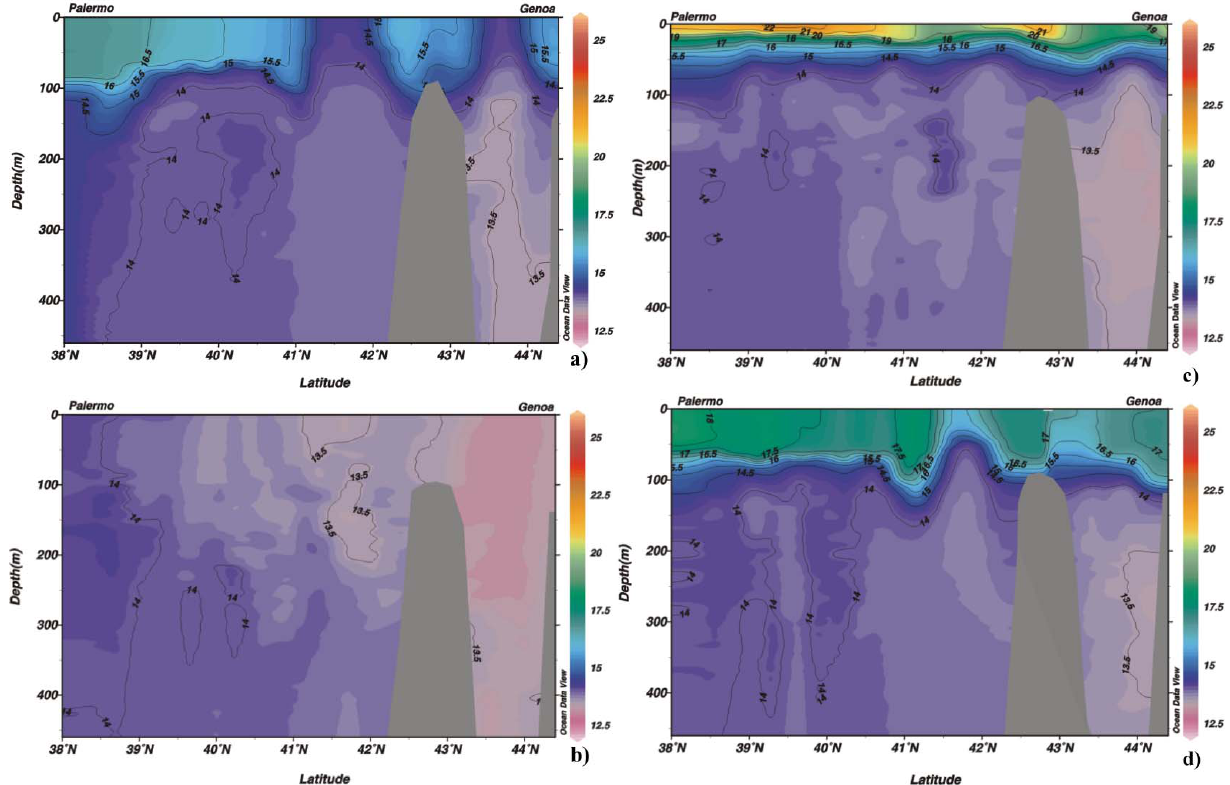
Fig. 4. Temperature sections from four XBT sections through the Tyrrhenian and Ligurian Seas: (a) 15–16 December 1999; (b) 22–23